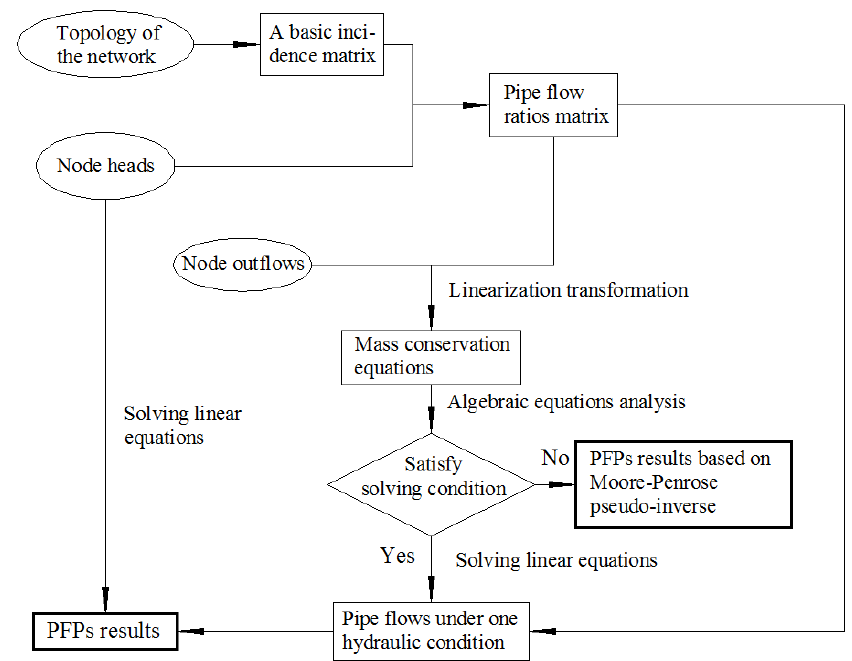
Figure 1. The main processes of the PFPs estimation